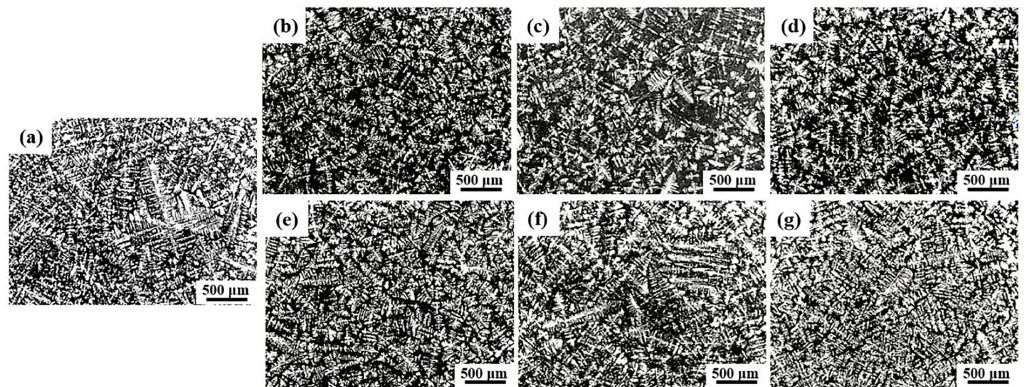
Figure 5. Microstructure of Al-9.5Si-1.5Cu-0.8Mn-0.6Mg alloys: ( a ) A0; ( b ) A1; ( c ) A2; ( d ) A3; ( e ) B1; ( f ) B2; ( g ) B3. Table 3. The Al-dendrite size of the SDAS of the alloy after refinement with Al-5Ti-0.25C-0.25B and Al-5Ti-1B master alloy.